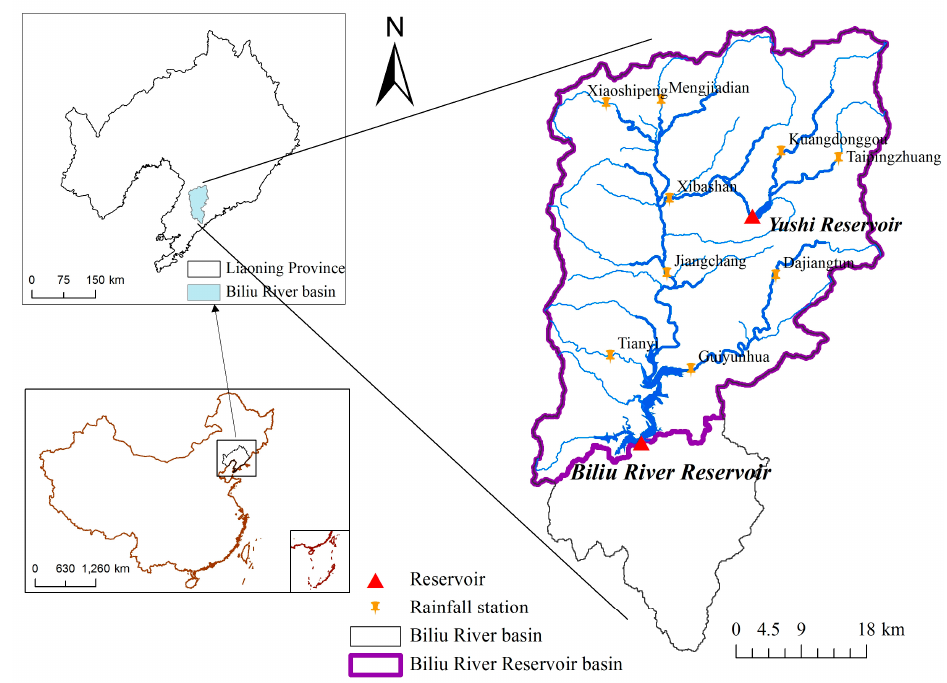
Figure 1. The Biliu River basin.